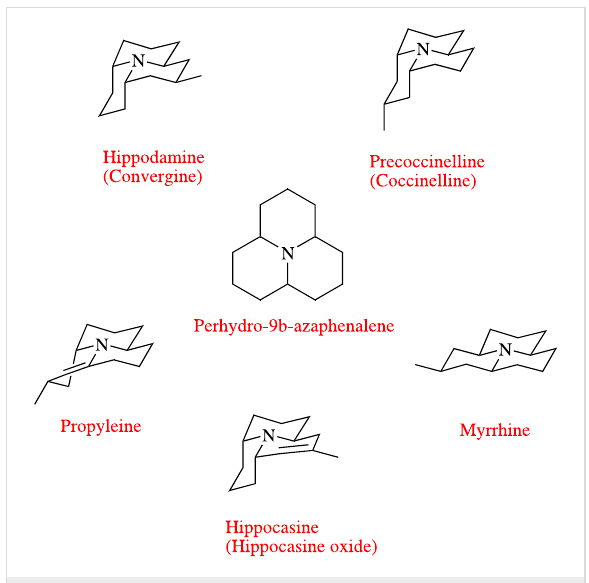
Figure 1: Structures of Coccinellid Alkaloids ( N -Oxides and their names in brackets).